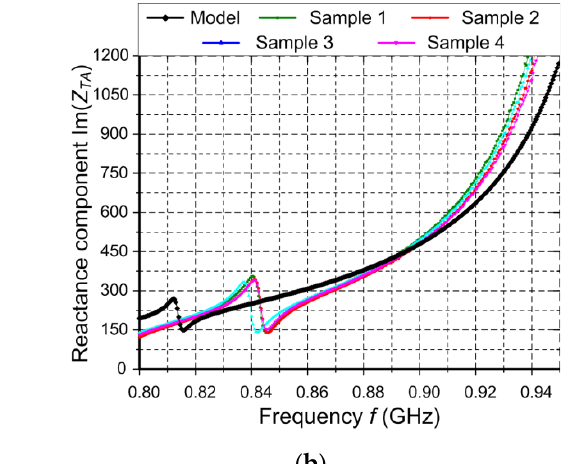
Figure 8. Elaborated model of two-antenna system: ( a ) Main components of model; ( b ) Electronic components taken in to consideration in simulation process; ( c ) Dimensions of RFID antenna ( d ) Dimensions of additional harvester antenna; FR408 — high performance laminate (Isola Group, Düren, Germany); IS680-300 — very low-loss laminate material (Isola Group) .